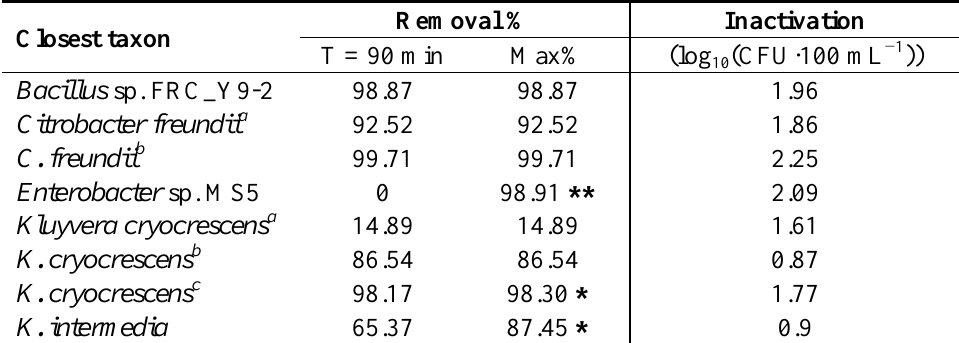
Table 3. Bacterial inactivation values and removal percentages obtained during analysis of the kinetics of